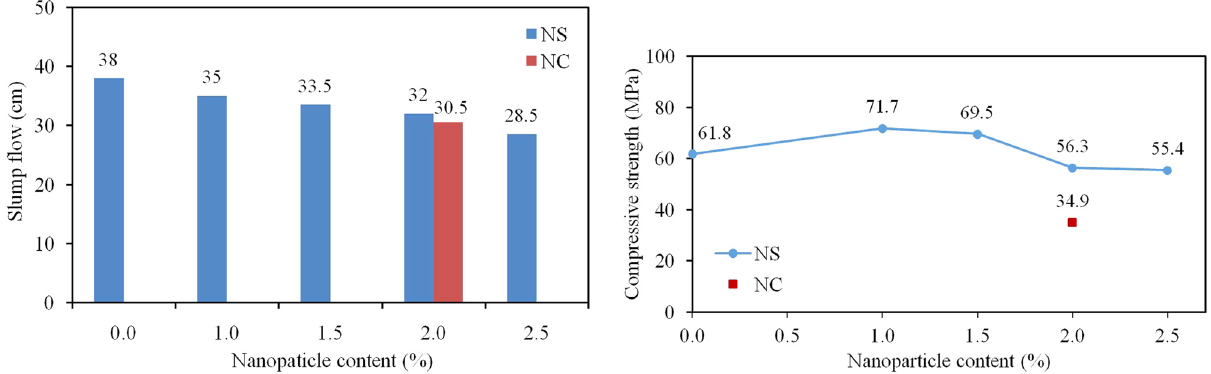
Figure 3: E ff ects of nanoparticle content and type on slump fl ow of cementitious composites.